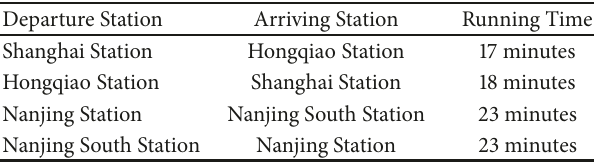
Table 3: Running time between different stations in the same hub. Departure